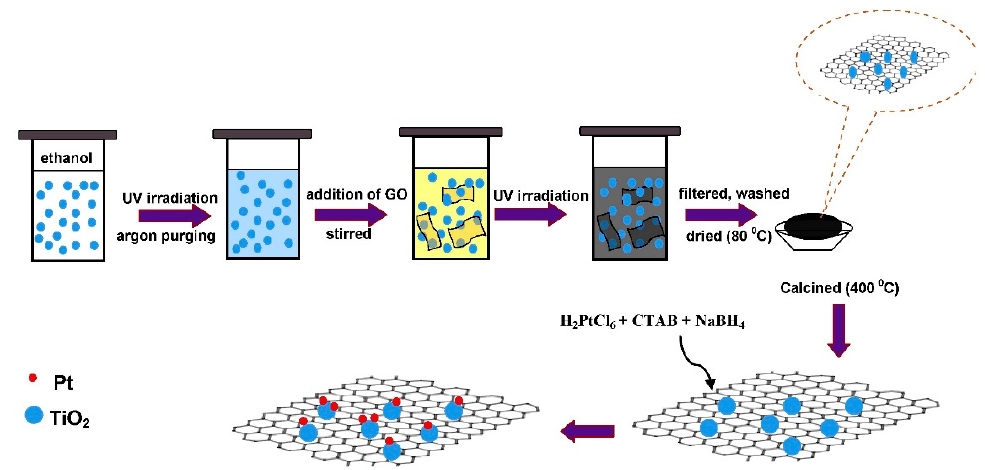
Figure 7. Schematic representation of the synthesis of TiO 2 /GO nanocomposites by mechanical mixing and sonication. Reprinted with permission from reference [17]. Copyright 2013